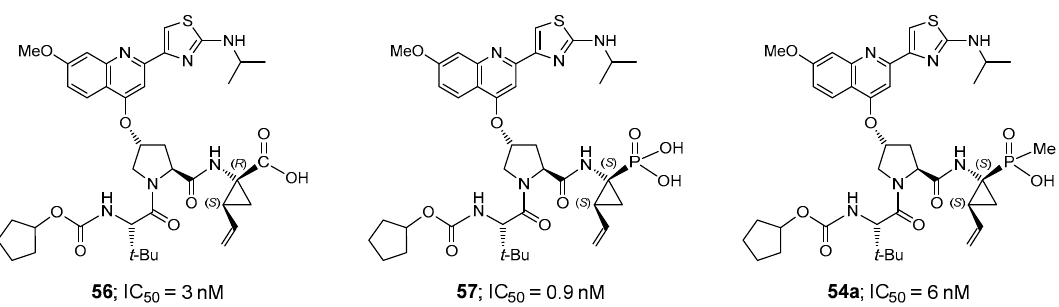
Figure 3. Carboxylic 56 , phosphonic 57 and C -phosphinic 54a analogs of BI-2061 and activities as inhibitors of the HCV NS3 protease.